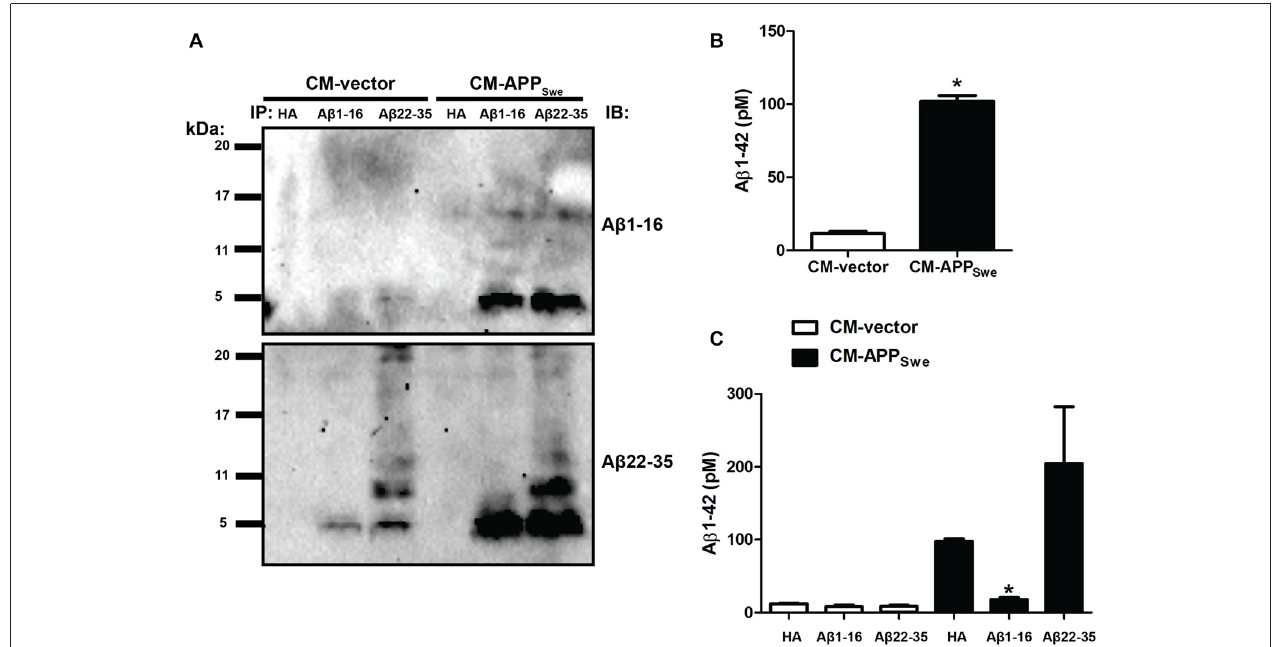
FIGURE 1 | β -amyloid (A β ) proteins are present in conditioned medium (CM) derived from SY5Y-CHT cells expressing APP Swe . (A) CM was collected from SY5Y-CHT cells that had been transiently transfected with either vector or APP Swe plasmids and allowed to express for 24 h (CM-vector and CM-APP Swe , respectively). A β was immunoprecipitated from CM-vector and CM-APP Swe using A β antibody directed at amino acids 1–16 of A β (anti-A β [1–16]) or A β antibody directed at amino acids 22–35 of A β (anti-A β [22–35]) and Protein G Sepharose. Proteins were solubilized, separated by SDS-PAGE and transferred to polyvinylidene difluoride (PVDF) membranes. Membranes were probed with anti-A β [1–16] (top panel) and anti-A β [22–35] (lower panel). Representative immunoblots show A β proteins present in CM-vector and CM-APP Swe . CM-vector and CM-APP Swe were incubated with anti-HA antibody and Protein G Sepharose as a negative control (lanes 1 and 4). The immunoblots shown are representative of data obtained from three independent experiments. (B) Human A β 1–42 concentration in CM-vector and CM-APP Swe as measured by ELISA. Data are the mean ± SEM of five independent experiments, with statistical analyses performed using a student’s paired t -test ( ∗ p ≤ 0.05). (C) CM-vector and CM-APP Swe were incubated with either HA, anti-A β [1–16] or anti-A β [22–35] for 24 h and A β 1–42 concentration was measured by ELISA. Incubating CM-APP Swe with anti-A β [1–16] significantly lowers A β 1–42 concentration compared to that found in CM-APP Swe incubated with either anti-HA or anti-A β [22–35] antibody. Data are the mean ± SEM of five independent experiments, with statistical analyses performed using a repeated-measures